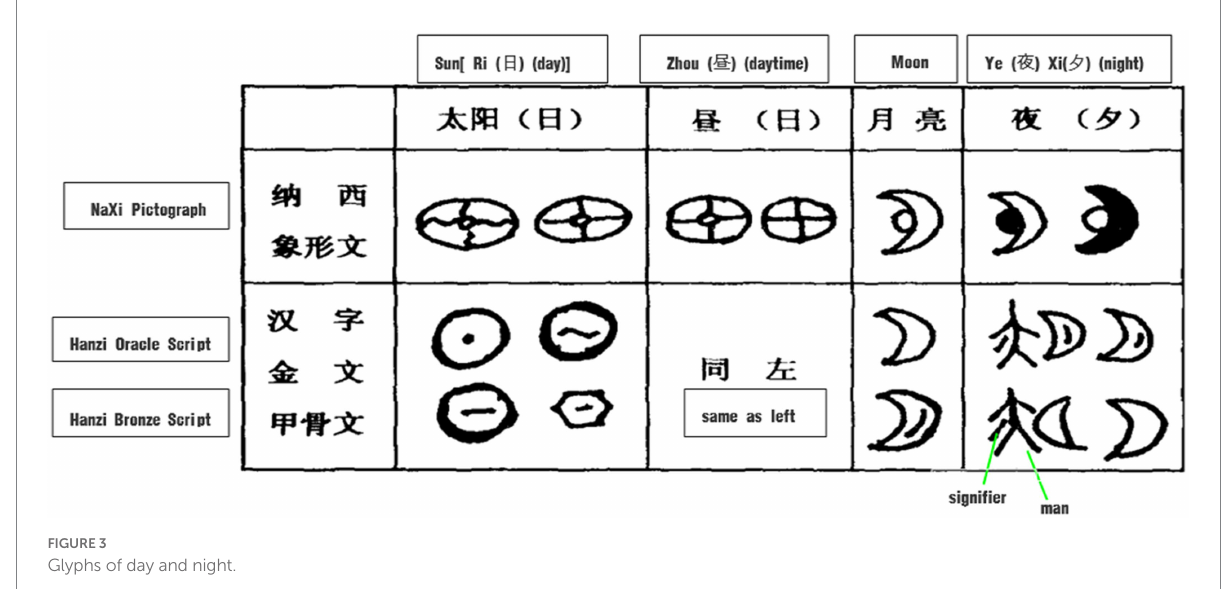
FIGURE 3 Glyphs of day and night.